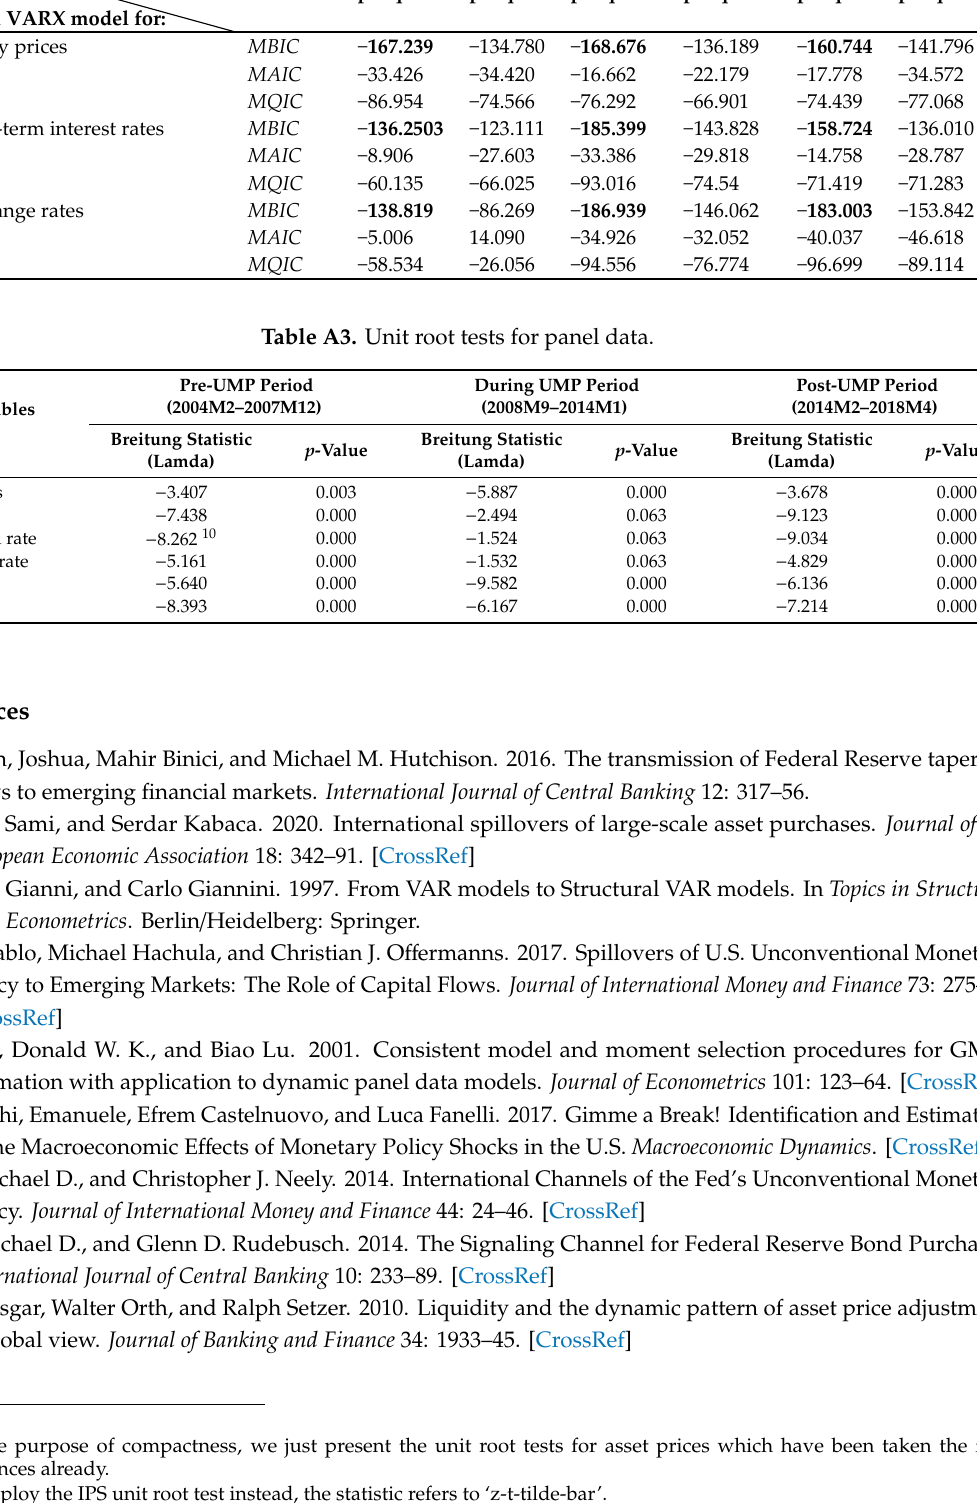
Table A1. Data description and sources . Variable